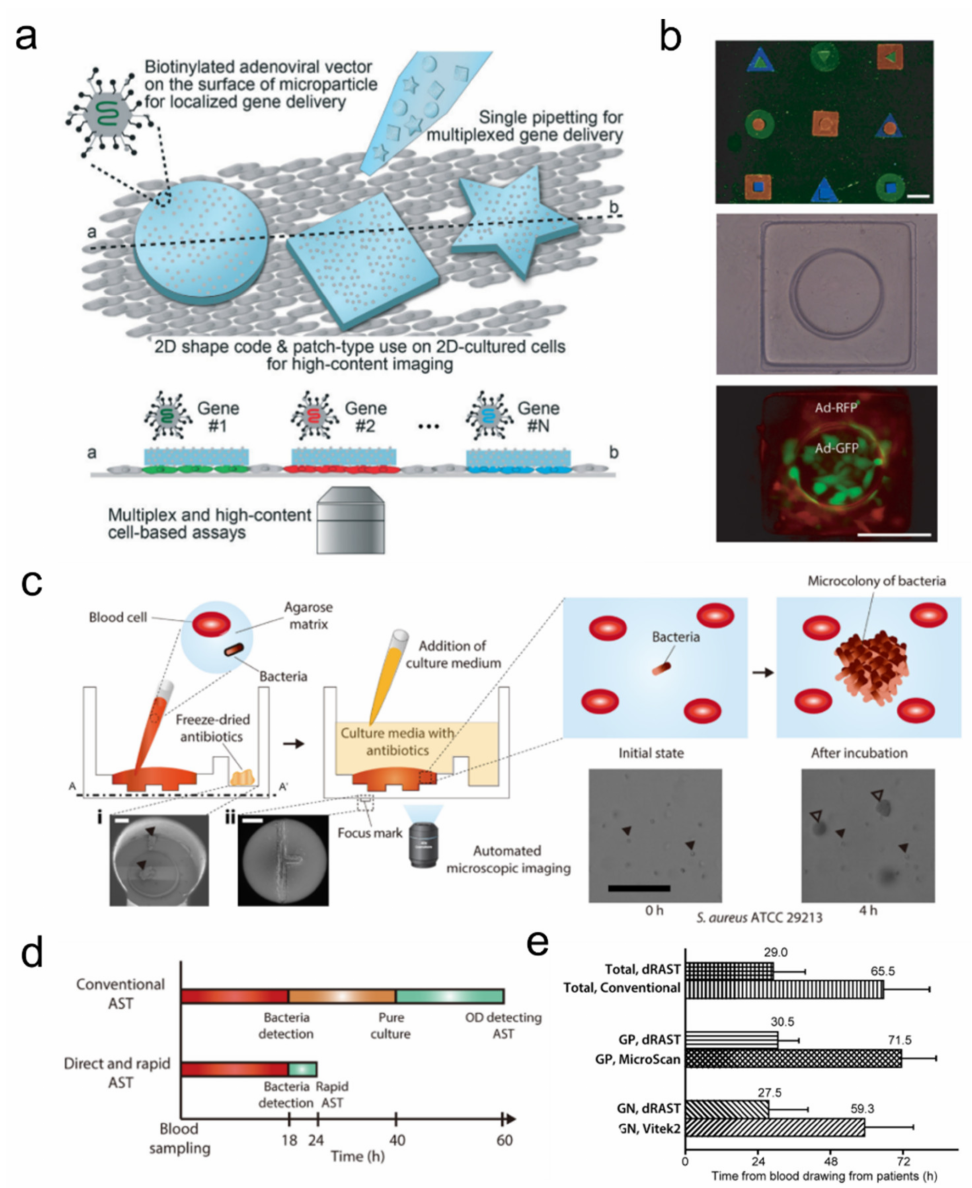
Figure 11. Microorganism-laden hydrogels for drug screening. ( a ) Schematic of encoded viral micropatch for multiplex cellular assays. Each shape-coded particle is conjugated with adenovirus with designated gene for localized gene transfer; adapted with permission from [142]. Copyright 2017 RSC. ( b ) Demonstration of hierarchically assembled shape-encoded hydrogel micropatch for dual gene delivery; adapted with permission from [143]. Copyright 2018 AIP ( c – e ). Direct detection of antibiotic resistance from positive blood culture bottle by image tracing of agarose-embedded bacteria cells; adapted with permission from [144]. Published under CC-BY license 2017. ( c , d ) Illustration of direct blood detection of single-bacteria microcolony by antibiotic-laden agarose hydrogel-embedding of blood. ( e ) Comparison of test duration between conventional AST and direct